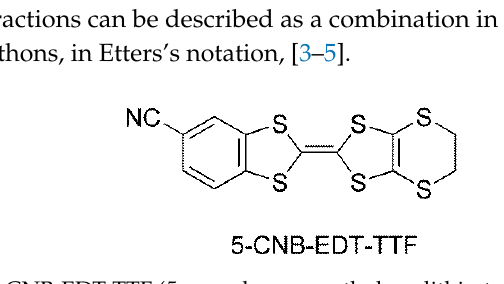
Figure 1. CNB-EDT-TTF ( 5 -cyanobenzene-ethylenedithio-tetrathiafulvalene ).